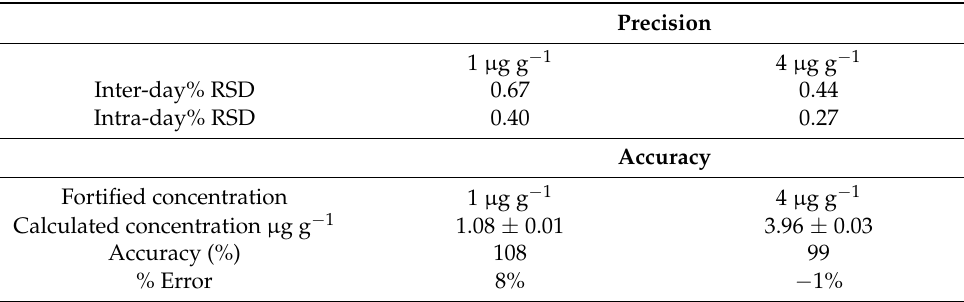
Table 2. C61-PCBM recoveries and instrument repeatability.